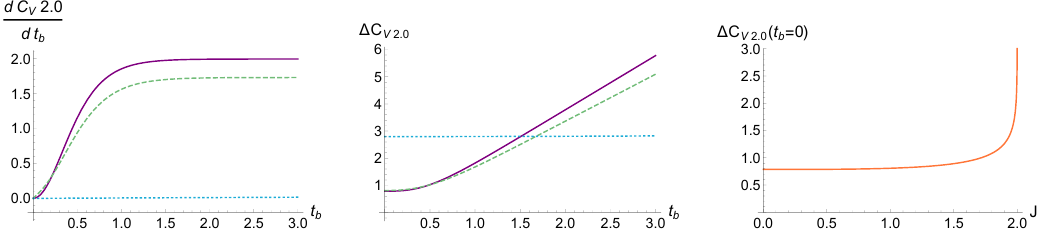
Figure 11 . (Left) dC V2 . 0 , (center) ∆ C V2 . 0 ( t b ) and (right) ∆ C V2 . 0 ( t b = 0) as a function of J for dt b M = 2 , ‘ = G N = 1 . In the left and center panels: J = 0 . 1 (purple solid), J = 1 (green dashed) and J = 1 . 999 (blue